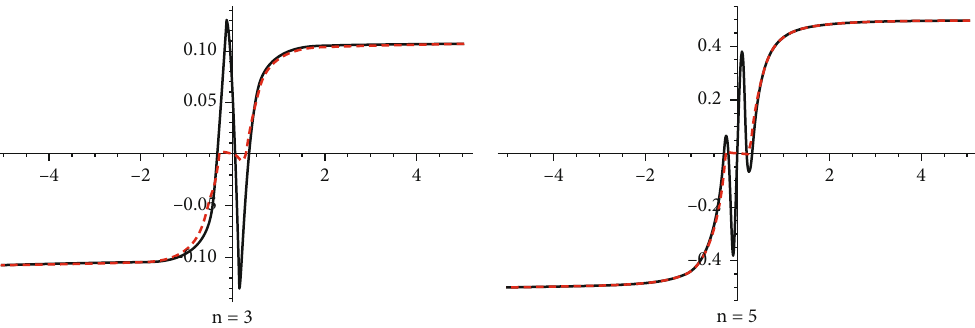
nz + 1 Þ for several values of n , whereas dashed lines represent the right-hand side of (30) with z ≡ x , n ð − 1 where α = 0 : 2